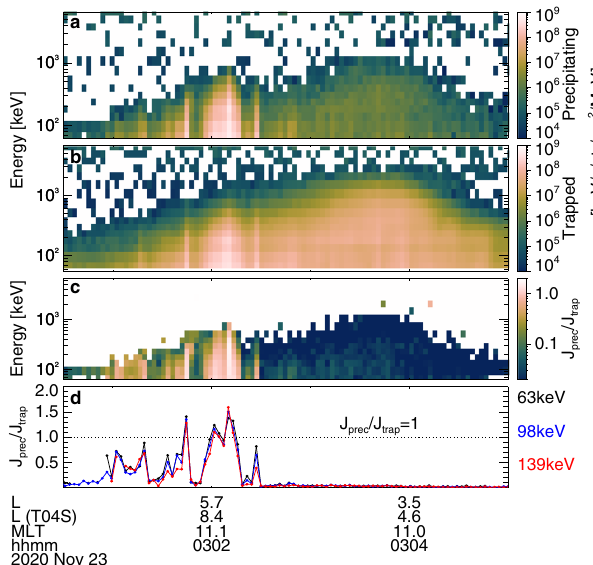
Fig. 2 Overview of ELFIN-A spacecraft observations on 23 November 2020. Energy spectra of a precipitating j prec ( E ) and b trapped j trap ( E ) electron fl uxes, c precipitating to trapped fl ux ratio j prec / j trap , d j prec / j trap at 63 keV, 98 keV, and 139 keV, with the dotted line showing j prec / j trap = 1. ELFIN-A ’ s L location from dipole and TS04 69 magnetic fi eld models ( L is the equatorial geocentric distance of the magnetic fi eld line, in Earth radii) and magnetic local time ( MLT ) are shown in the bottom.